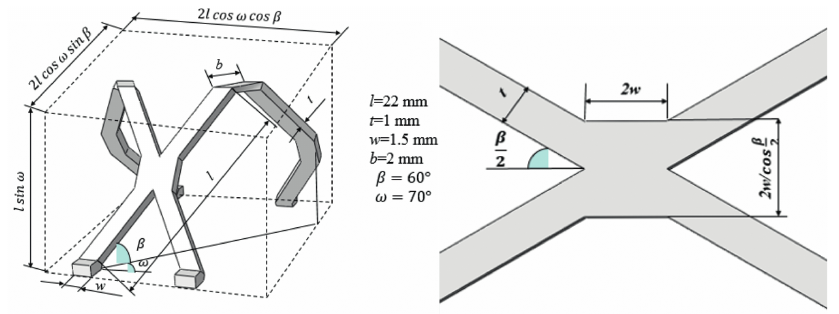
Figure 2: Finite element model of a unit cell.